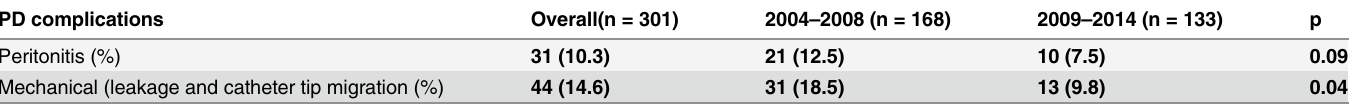
Table 3. Mechanical and infectious complications related to high volume peritonealdialysis according to time period.